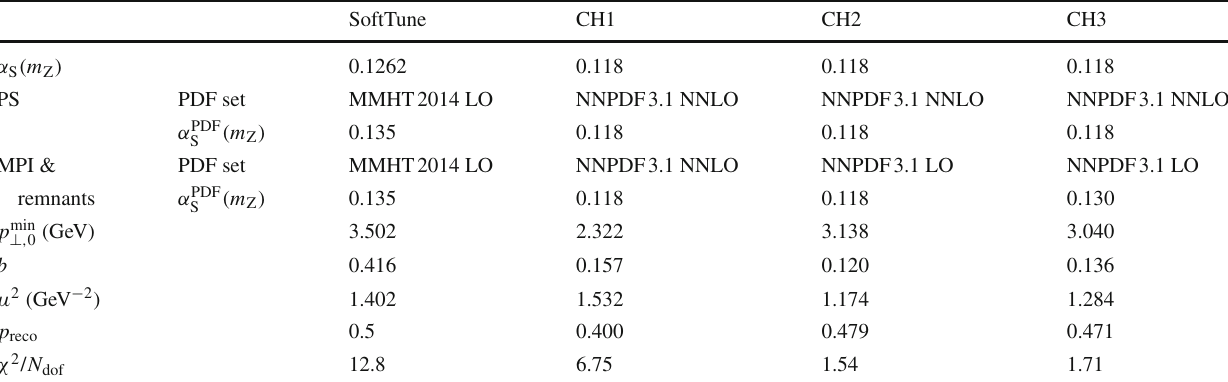
Table 2 Value of the parameters for the SoftTune [3,12], CH1 , CH2 , and CH3 tunes